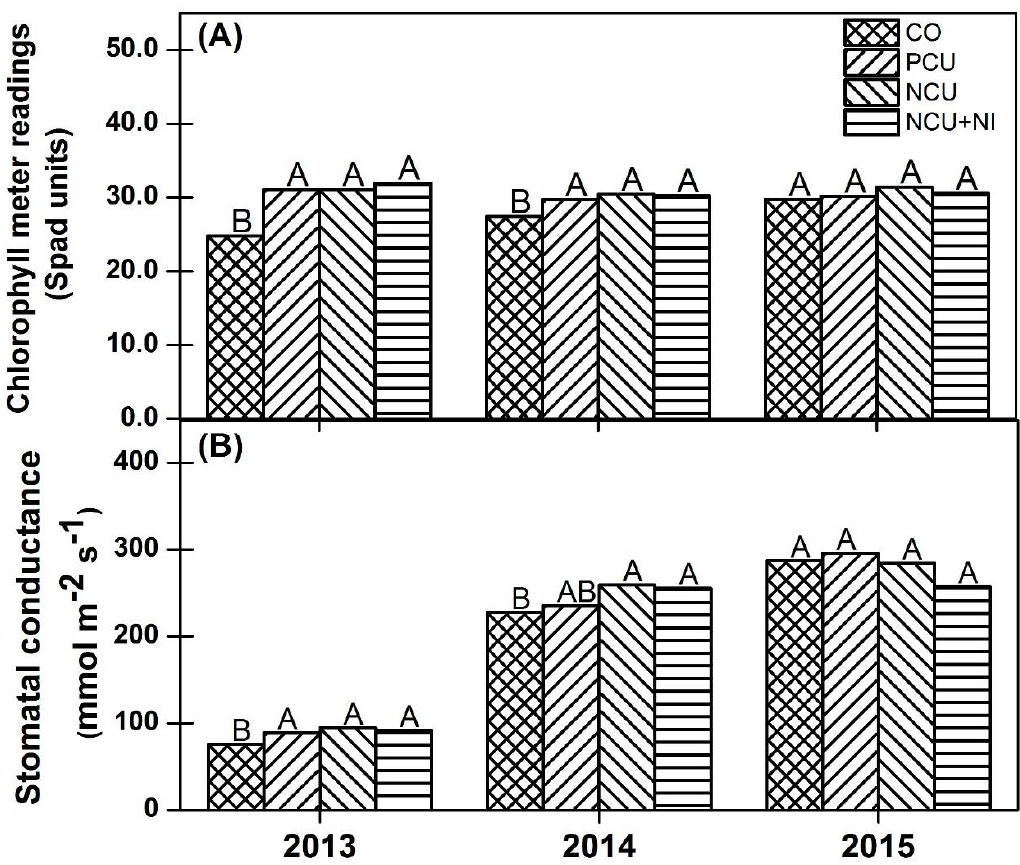
Figure 3. Chlorophyll meter readings ( A ) and stomatal conductance ( B ) taken during the waterlogging as affected by main effects of pre-plant N fertilizer sources events in 2013, 2014 and 2015 growing season. Data were averaged over the waterlogging duration and corn hybrids due to absence of their interaction with pre-plant N fertilizer sources. The similar letter on the bars indicate no significant differences between means at p < 0.10. Means are compared separately for each year. Abbreviations: CO, non-fertilized control; NCU, non-coated urea; PCU, polymer coated urea; NCU + NI, non-coated urea + nitrification inhibitor; NR, no rescue N application; NCU + UI, non-coated urea + urease